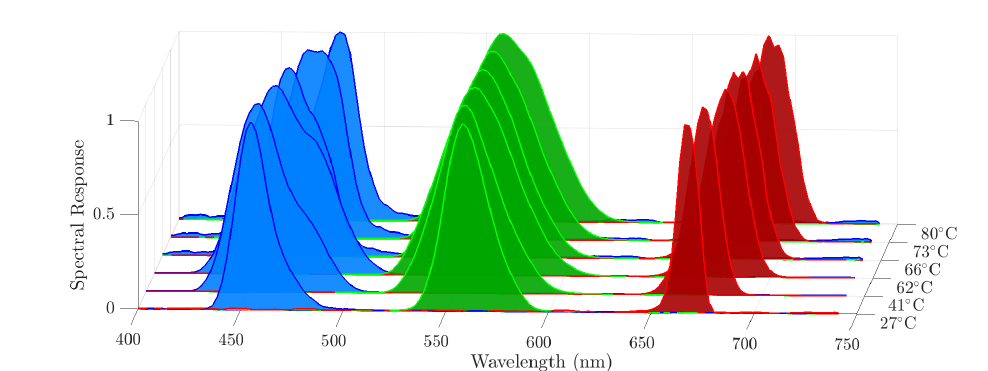
Figure 5. Emission spectra at different p-n junction temperatures.